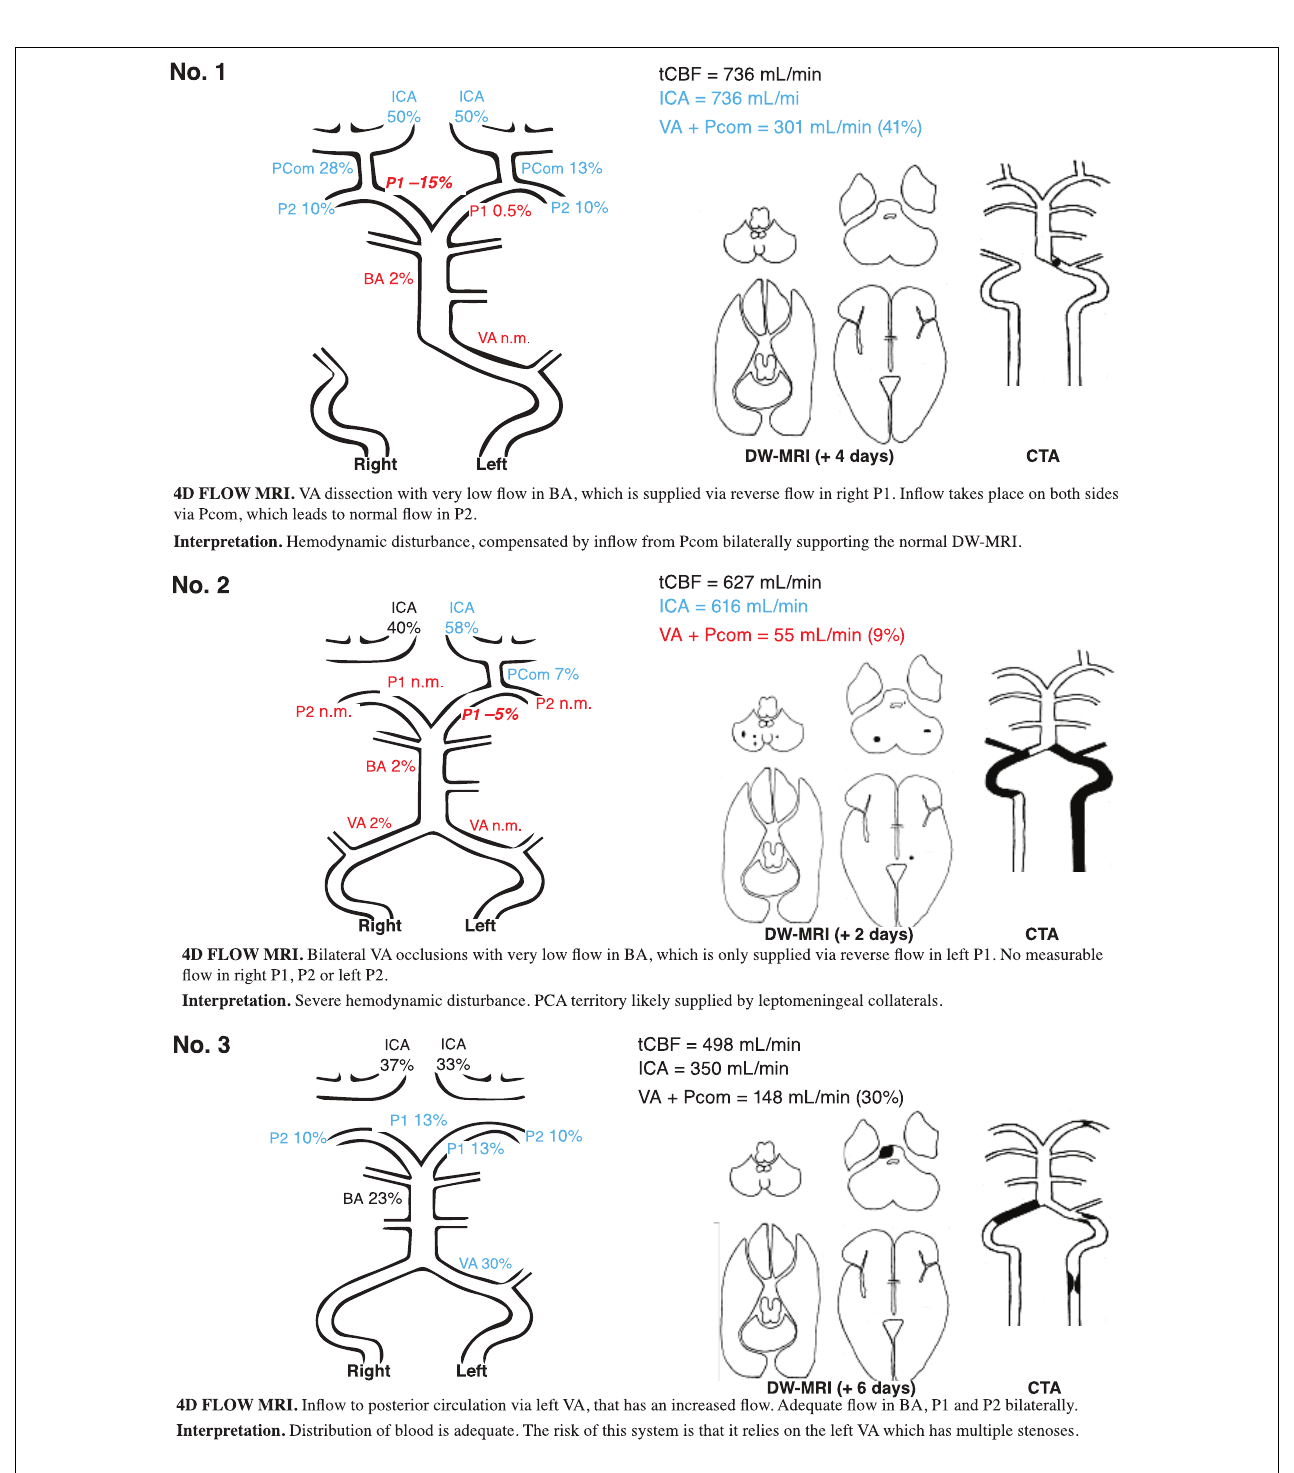
FIGURE 3 | DW-MRI, CTA, and 4D flow MRI findings in three illustrative cases. Blood flow rate is presented in percent of total cerebral blood flow. Patient no. 1 had signs and symptoms corresponding to a Wallenberg syndrome and PICA infarct, however, without any DW-MRI lesion in the brainstem or cerebellum. CTA revealed a left-sided distal VA dissection. Clinical symptoms disappeared within weeks. Patient no. 2 had an acute onset of vertigo, dysarthria, and alternating left- and right-sided hemiparesis. In the aftermath, the patient had symptoms compatible with hypoperfusion (dizziness at exertion) but was deceased due to malignancy unrelated to the stroke about 1 year later. Patient no. 3 had dizziness, dysarthria, facial palsy, slight left-sided hemiparesis, and an ataxic gait disturbance. The patient did not have any neurological symptoms at follow-up. DW-MRI, diffusion-weighted magnetic resonance imaging; CTA, computed tomography angiography; blue, high flow; red low flow; black, flow within normal limits; VA, vertebral artery; BA, basilar artery; P1 and P2, segments of posterior cerebral artery; Pcom, posterior communicating artery; ICA, internal carotid artery; n.m., visible artery but flow not measurable; PICA, posterior inferior cerebellar artery.